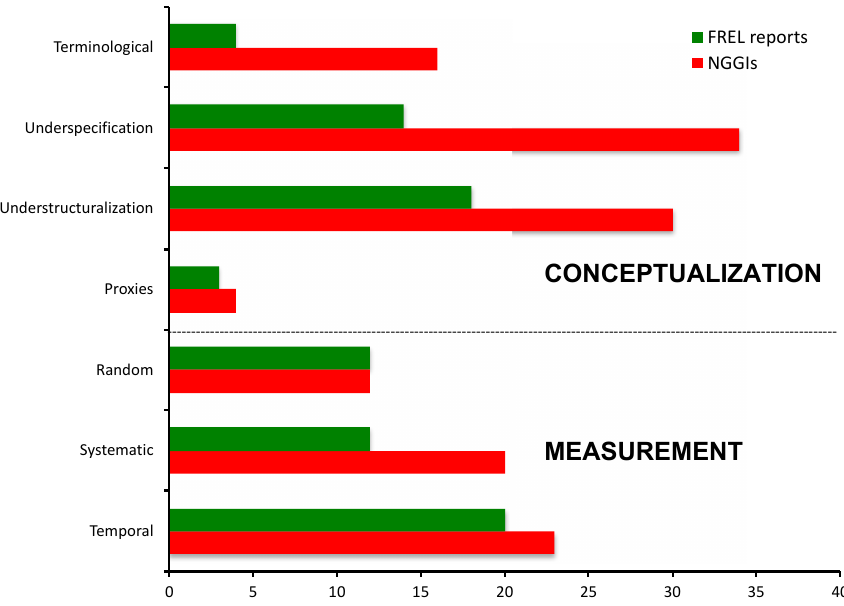
Figure 9. The numbers of conceptualization uncertainties and measurement uncertainties in the Uncertainty Fingerprints for twelve tropical countries of estimates in National Greenhouse Gas Inventories (NGGIs) and Forest Reference Emission Level (FREL) reports [54–77].